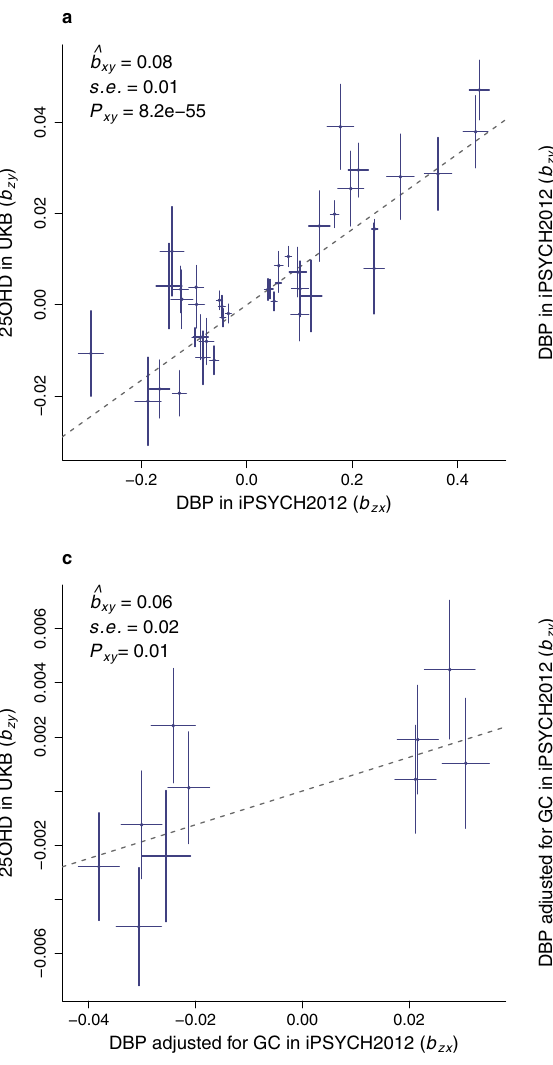
Fig.5|TheassociationofDBPand25OHD. Panels( a , b )showtheGSMRresultsof DBPconcentration, a theeffectofDBPon25OHD(SNPs n =40);and b theeffectof 25OHD on DBP (SNPs n =201). The GSMR estimates are shown in each panel. The plots show the GSMR estimate of effect, and SE and P value, all of which were calculated by GSMR. P value was estimated from a two-tailed test. The dashed